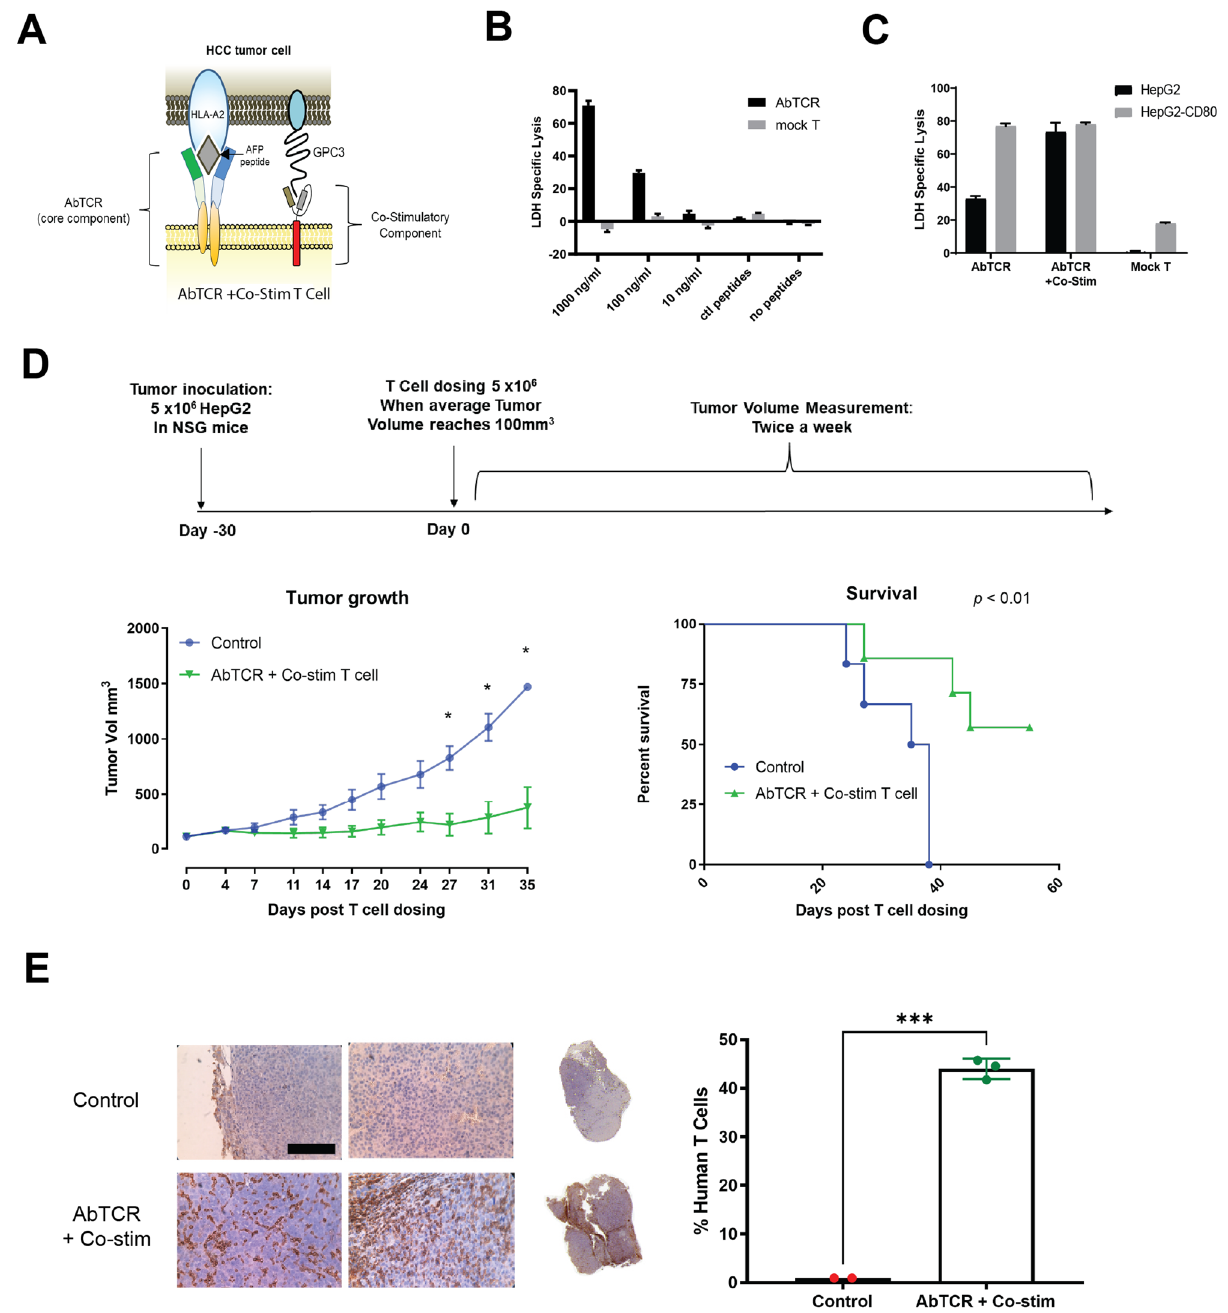
Figure 1. AbTCR + co-stim T cells mediate antigen-specific responses in vitro and in vivo. ( A ) Schematic design of the AbTCR + co-stim T-cell. LDH release was measured as a proxy for T cell-mediated target cell lysis in peptide-loaded T2 cells ( B ) and HepG2 cells ( C ). A total of 20 HLA-A*02 presented, non-AFP related peptides (sequences in Methods) were used as control peptides (ctl peptides in B). ( D ) NSG mice were inoculated with HepG2 cells and treated intravenously with one dose of 5 × 10 6 T cells when tumors reached approximately 200 mm 3 , using the AbTCR + co-stim as an experimental arm and a CD19-targeting construct as control arms (n = 6 NSG mice/group). Efficacy was measured as the average volume of HepG2 subcutaneous tumors and the rate of animal survival. ( E ) Tumor infiltrating lymphocytes (TILs) in HepG2 subcutaneous tumors were analyzed by immunohistochemical staining for human CD3. Representative images are shown for one tumor of each group with two areas at 40 × magnification (left) and 1 × whole-mount (right). Scale bar in 40x, 100 μm. Quantification of human T cells in the tumors was performed by counting CD3 positive cells and total cells in different areas throughout the section. Each data point represents one tumor sample. Statistical significance indicated as *, p < 0.05; ***, p < 0.001; ****, p <